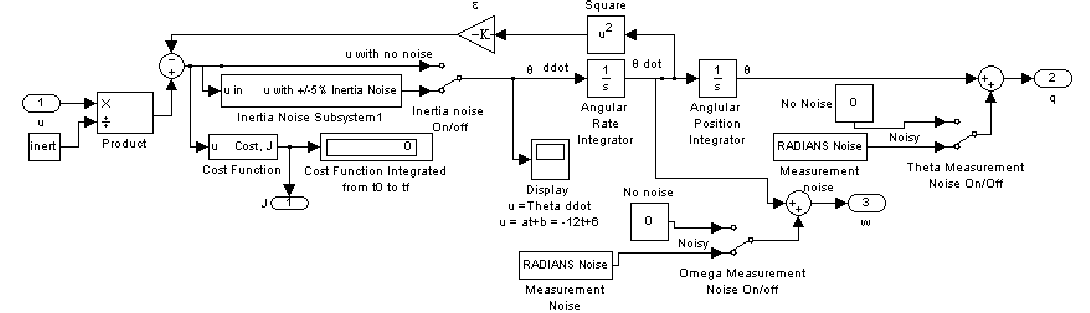
Figure A13. Mismodeled plant inserted into previous programming.